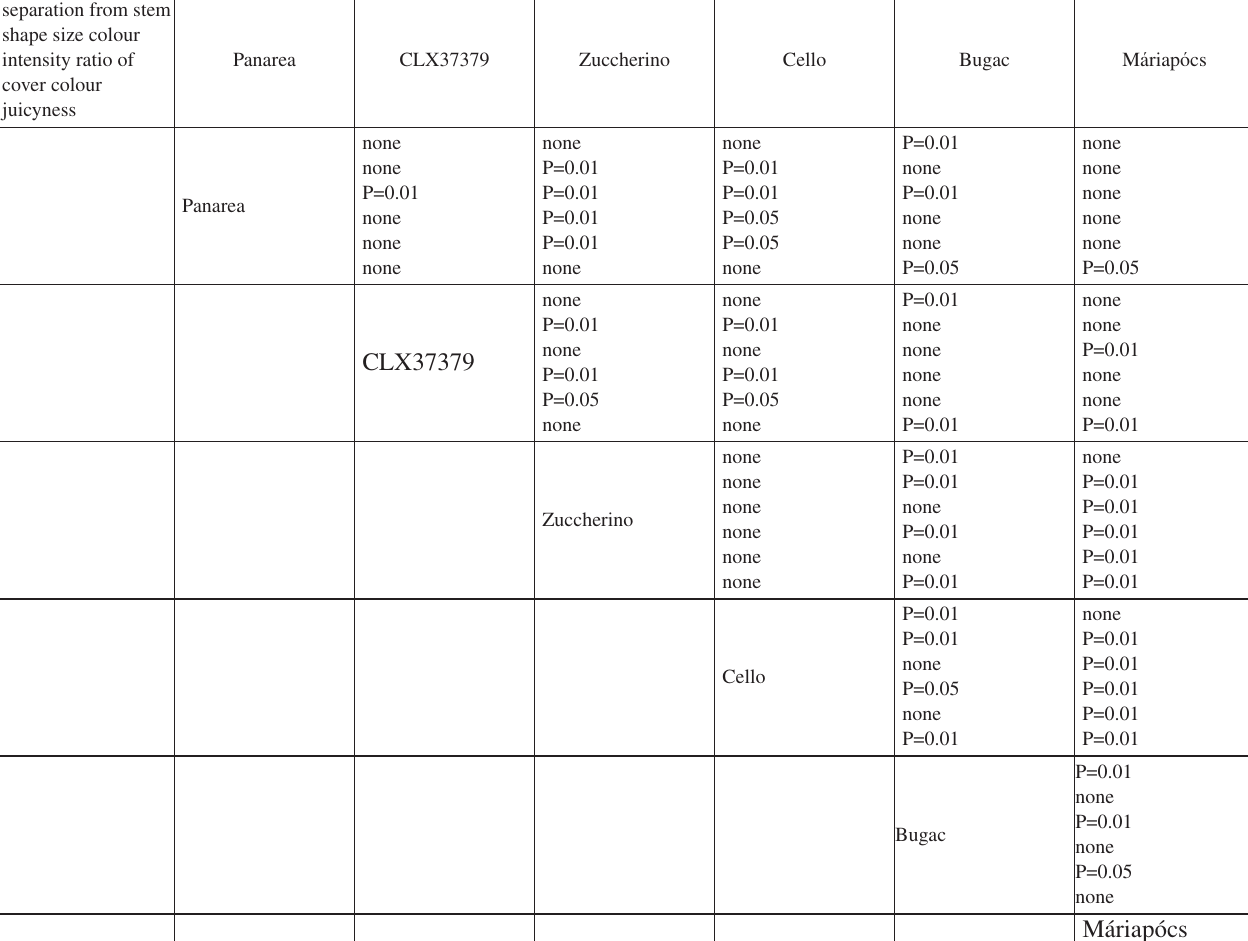
Table 3. Significant differences of significance attributes of tomato varieties